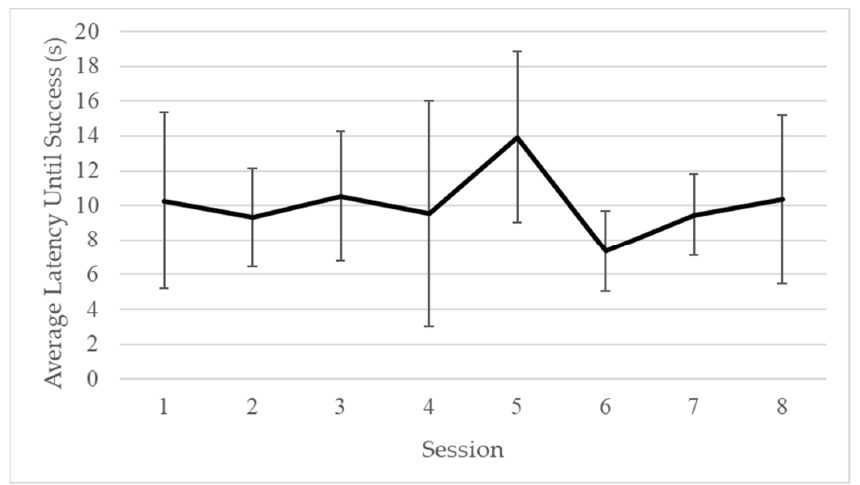
Figure 6. Time until success across sessions in Phase 2. Error bars depict standard deviations.